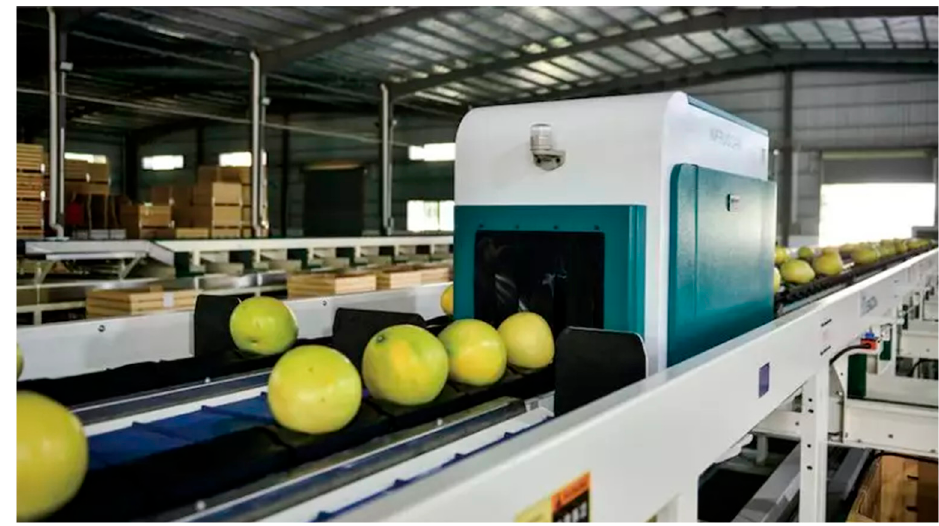
Figure 2. The pomelo sorting machine. Rollers on the conveyor belt can rotate the pomelo. The pomelo triggers the photoelectric switch to capture images by the cameras which have 1280 × 1024 resolution and a rate of up to 60 frames per second. When the cameras capture images, the pomelo rotates with the roller to obtain the information of the whole surface of one pomelo. As shown in Figure 3, the pomelo region is extracted after applying preprocessing methods to every image. Figure 3. The eleven images captured while the pomelo rotating.